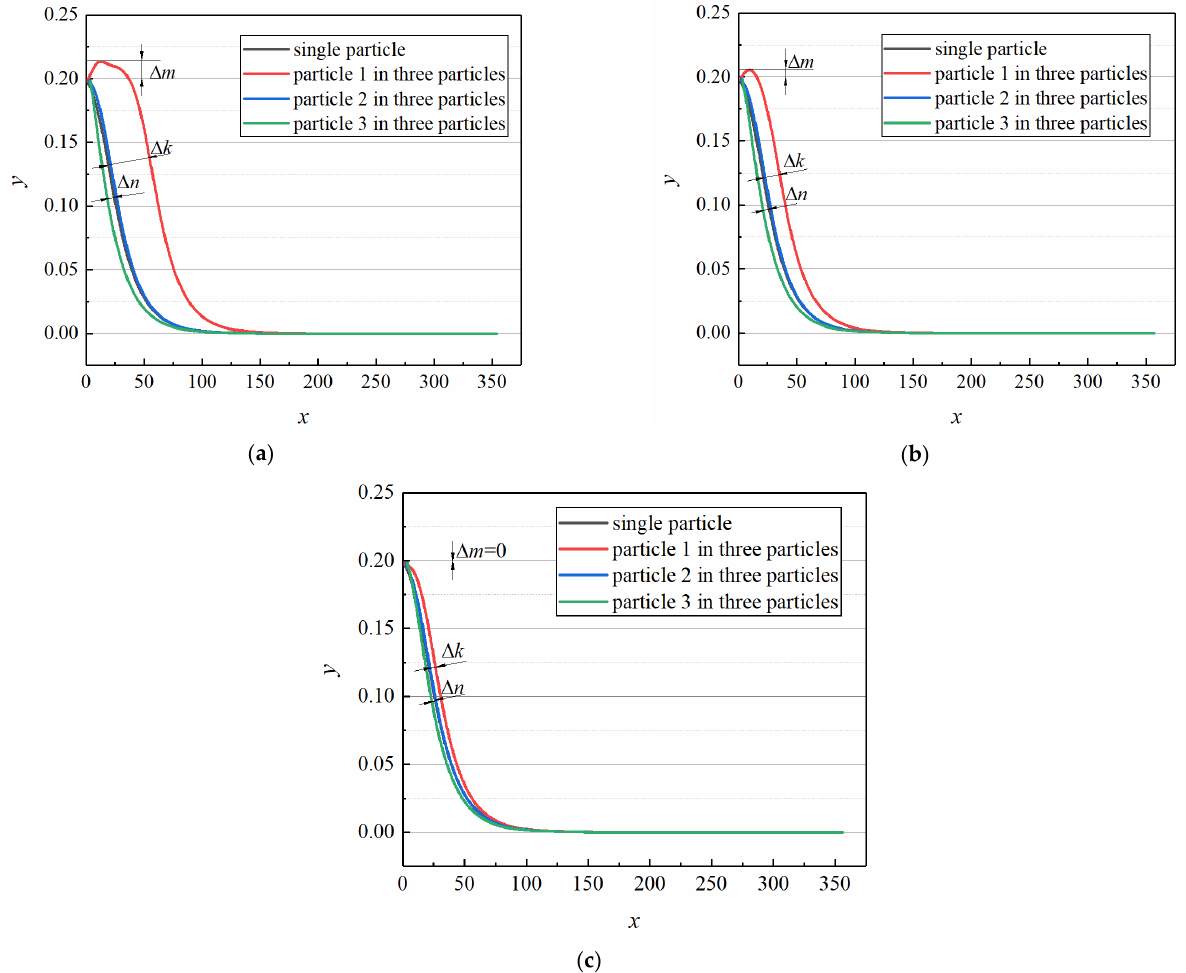
Figure 16. Trajectories of particles for different initial interparticle distances ( Wi = 0.5, η r = 0.3, α = 0.3, ε = 0.3, y 0 = 0.2) ( a ) d 0 = 0.8; ( b ) d 0 = 0.85; ( c ) d 0 = 1.0.